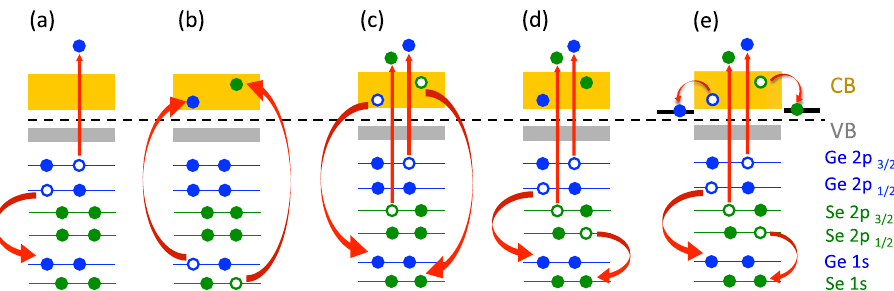
Fig. 2 Schematic overview of working principle of the core – hole clock spectroscopy. a Normal Auger process. b Resonant photoexcitation from core level to conduction band. c Participator decay process. d Spectator decay process. e Charge delocalization or charge transfer process. CB and VB indicate conduction band and valence band, blue solid circles and hollow circles indicate electrons and holes from Ge core levels, and green solid circles and hollow circles indicate electrons and holes from Se core levels,